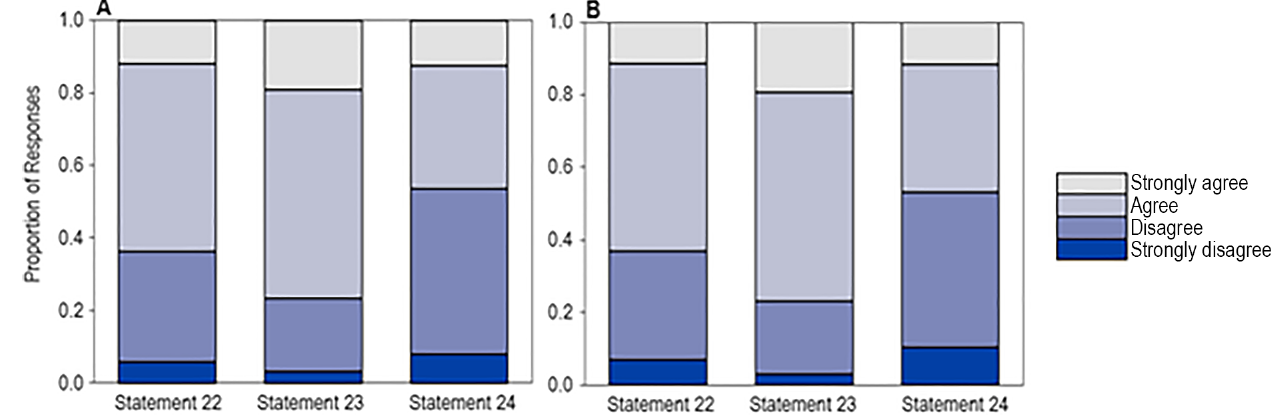
Figure 4. Overall Likert results for zoo animal perception statements for ( A ) the sloth experiment and ( B ) the python experiment. Statement 22: “ Animals in zoos are healthy and comfortable ”. Statement 23: “ Zoo staff provide the animals in their care with a high quality of life ”. Statement 24: “ Keeping sloths (pythons) in zoos, no matter how large and attractive their surroundings are, strikes me as cruel and unusual ” .